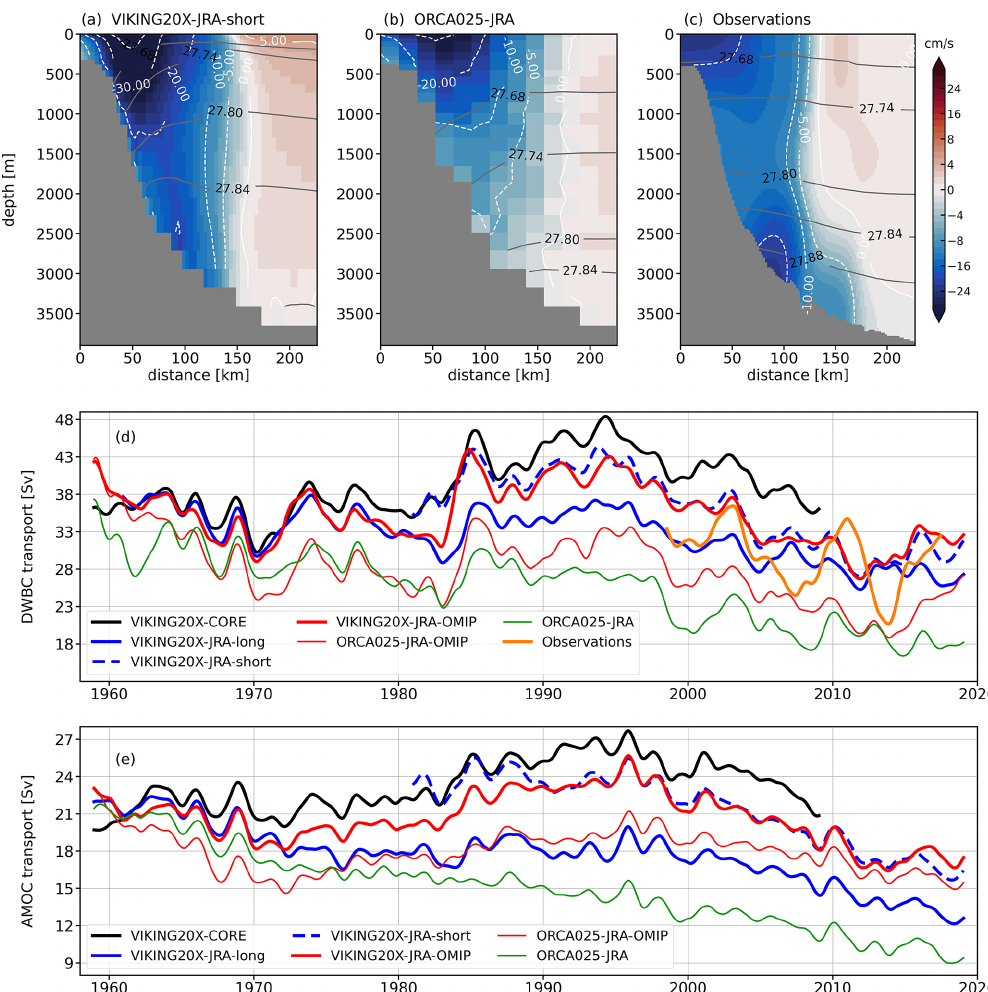
Figure 11. Mean sections (a, b, c) of velocity and σ 0 isolines (1997–2009) at 53 ◦ N in (a) VIKING20X-JRA-short, (b) ORCA025-JRA and (c) observations (non-linear colour map is used with intervals given of 1Sv between − 8 and 8Sv, and 2Sv beyond that range). Time series of (d) the DWBC export across 53 ◦ N characterised by the NADW defined by σ 2 criteria (Table 5), following the analysis of Handmann et al. (2018) and (e) the AMOC transport in σ 2 density coordinates at 53 ◦ N. Table 6. Mean and standard deviation (SD) based on monthly (mon) averaged as well as interannually (ia) filtered data of the transport (in Sv) through Florida Strait for the period 1990–2009. In this period, data coverage from cable measurements is